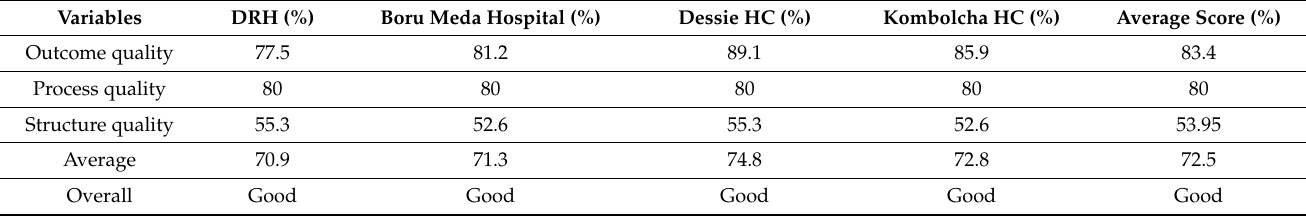
Table 4. Overall quality of TB care and treatment at public-health facilities in Northeast Ethiopia from January to April